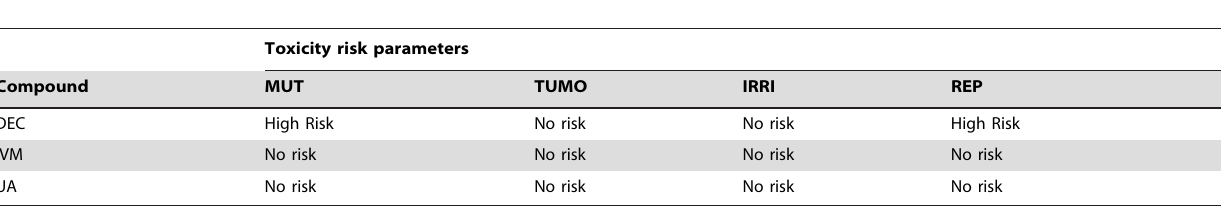
Table 5. Details of computational toxicity risk parameters of DEC, IVM and UA calculated by OSIRIS.